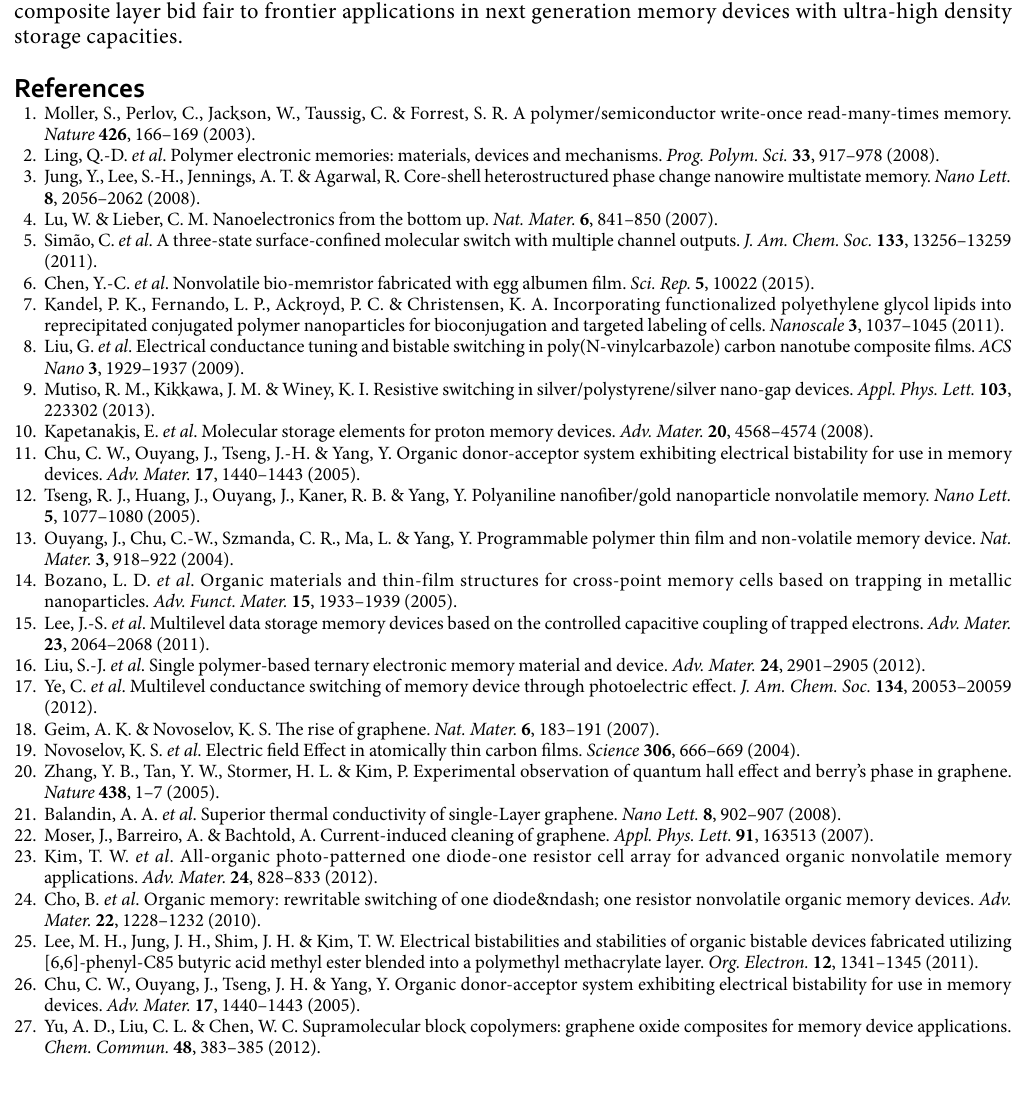
9 Scientific RepoRts | 7: 3938 | DOI:10.1038/s41598-017-04299-z